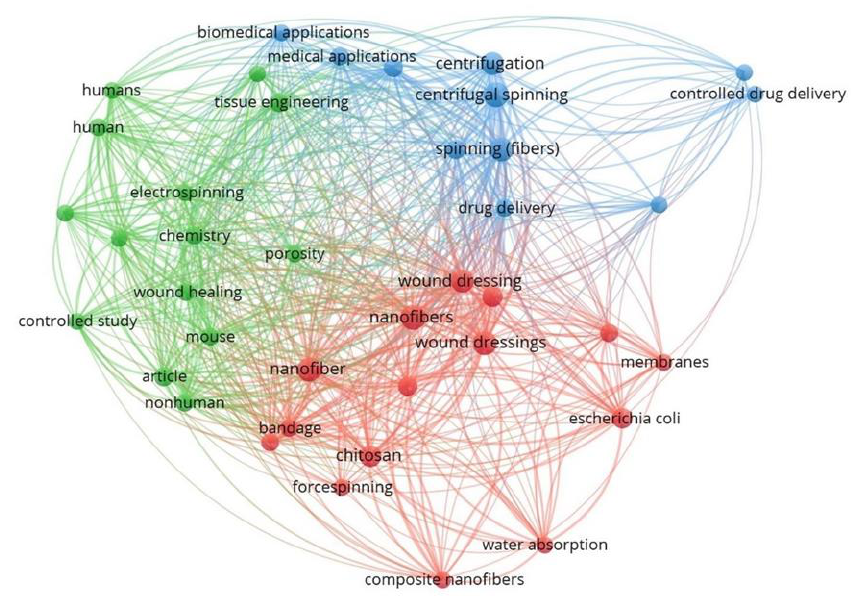
Figure 2. Publications about the RJS technology and the areas related to it in a bibliometric analysis performed by the free software VosViewer [65] with Scopus data.